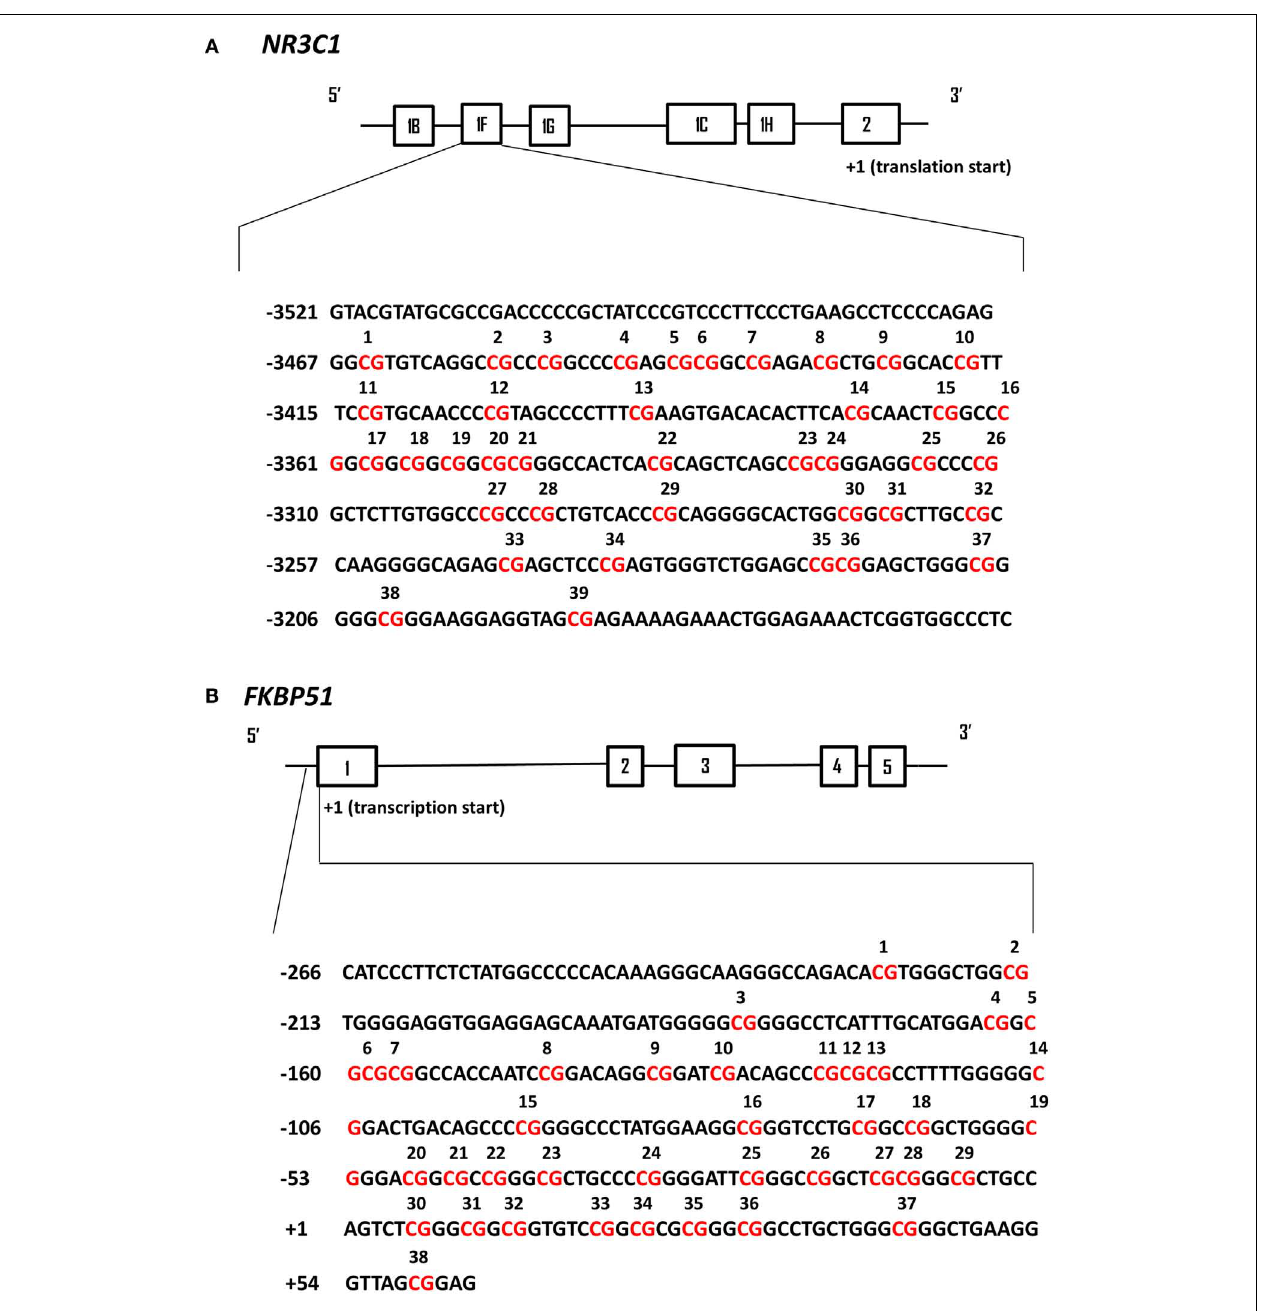
numbering of exon 1F promoter is based on the translational start site ( + 1).The CpG sites that have been analyzed by bisulfite sequencing are in red and numbered. (B) The FKBP51 gene proximal promoter region is numbered based on the transcriptional start site ( + 1) of exon 1.The CpG sites that have been analyzed by bisulfite sequencing are in red and